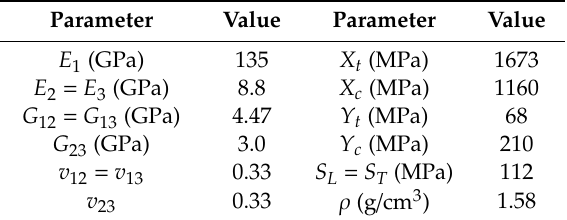
Table 3. Material mechanical properties for the specimens.